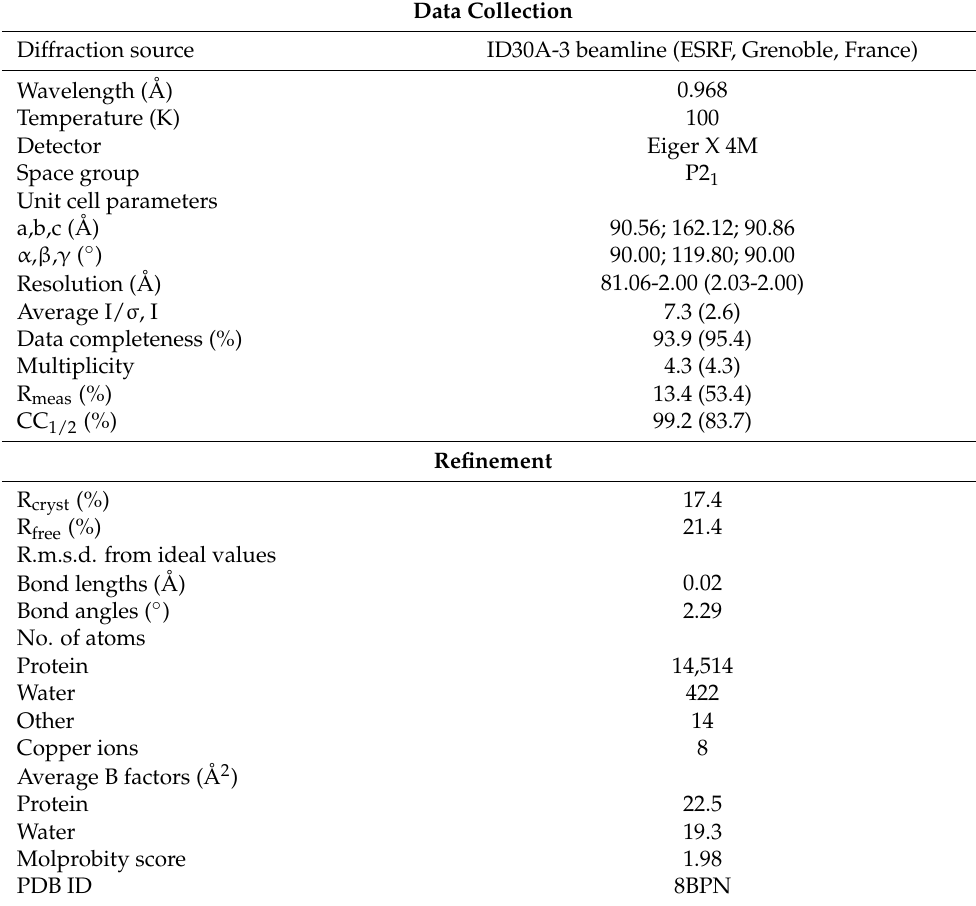
Table 1. Data collection and refinement statistics for TcDH F436Q . Data for the highest resolution shell are shown in